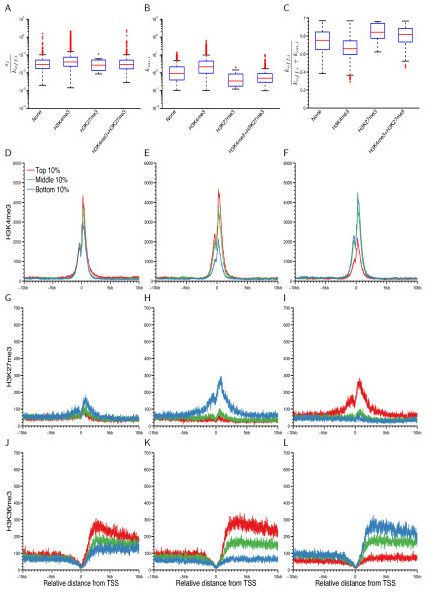
Correlation of transcriptional kinetics with histone modifications in mouse ES cells. (A)-(C) Box plots that compare burst size (A), burst frequency (B), and the average fraction of time that a gene spends in the inactive state (C) in the four groups. Given the annotated chromatin state of the two histone modifications by [33], we classified all expressed genes with a normalized read count greater than 50 in at least one cell that have chromatin state annotations into four groups: H3K4me3 only (n = 6,291), H3K27me3 only (n = 10), H3K4me3 + H3K27me3 (n = 630) and none (n = 492). The H3K4me3 group is significantly different from the others except the H3K27me3 group: P < 10-16 for si/kon,i, P < 10-16 for kon,i, P < 10-16 for koff,i/(koff,i + kon,i), by the Mann-Whitney U-test. Due to the small number of samples of the H3K27me3 group, the H3K4me3 group is less significantly different from the H3K27me3 group: P = 0.0486 for si/kon,i, P = 2.73 × 10-5 for kon,i, P = 8.12 × 10-5 for koff,i/(koff,i + kon,i). In each box plot, the central red line indicates the median value, the top and bottom edges of the box are the 75th (q3) and 25th (q1) percentiles, and the ends of the whiskers denote q3 + 1.5(q3 - q1) and q1 - 1.5(q3 q1). (D)-(L) The profiles of H3K4me3, H3K27me3, and H3K36me3 ChIP-seq reads mapped near TSSs (Transcription Start Sites) are shown for genes with values of the three kinetic quantities in the top 10% (red), middle 10% (green), and bottom 10% (blue) of the relevant distribution. The y-axis is the total number of reads mapped to each position.